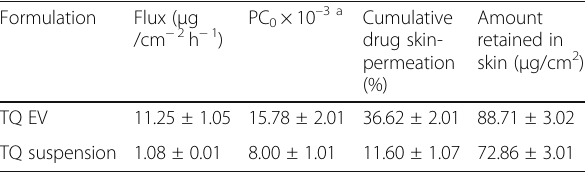
Table 3 Skin-transport parameter obtained for various test formulations (Mean ± SD) Formulation